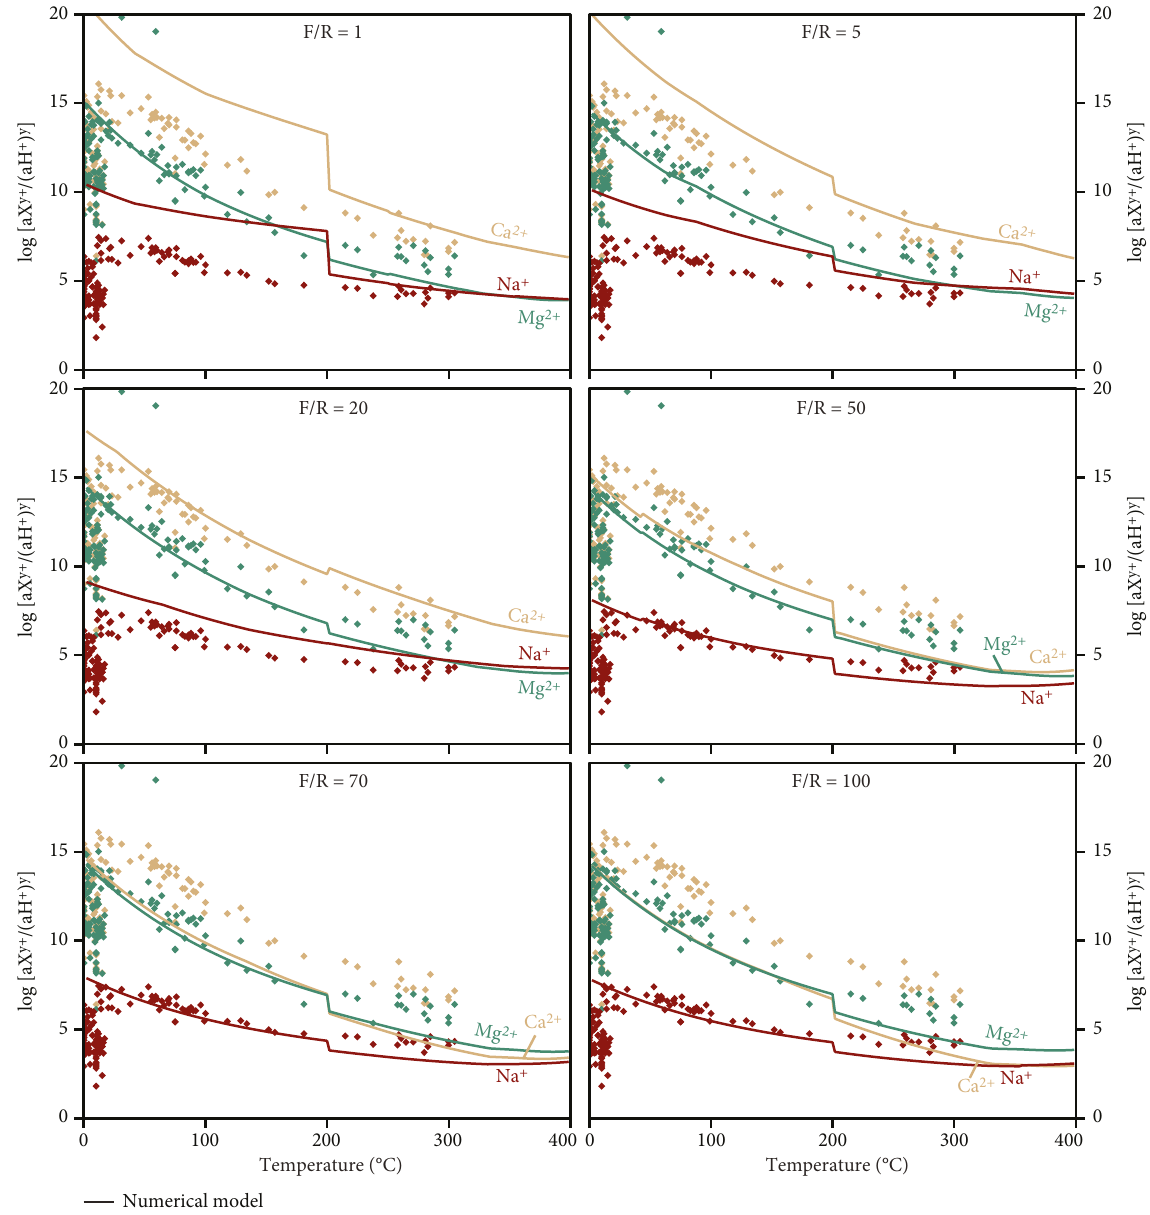
Figure 4: Comparison between simulated fl uid composition (lines) and natural waters from Iceland (diamond symbols) showing selected cation to proton activity ratios as a function of temperature for variable fl uid/rock (F/R) mass ratios. The seawater-basalt simulations were carried out from 2 to 400 ° C, 500 bars, and variable fl uid/rock mass ratios. The fl uid compositions from the model possess near-seawater salinity values while Icelandic waters are characterized by low-salinity dilute meteoric spring waters and geothermal spring waters. Data for natural Icelandic waters from Stefánsson et al. [63] and Stefánsson and Arnórsson [108] (X=cation; y=cation